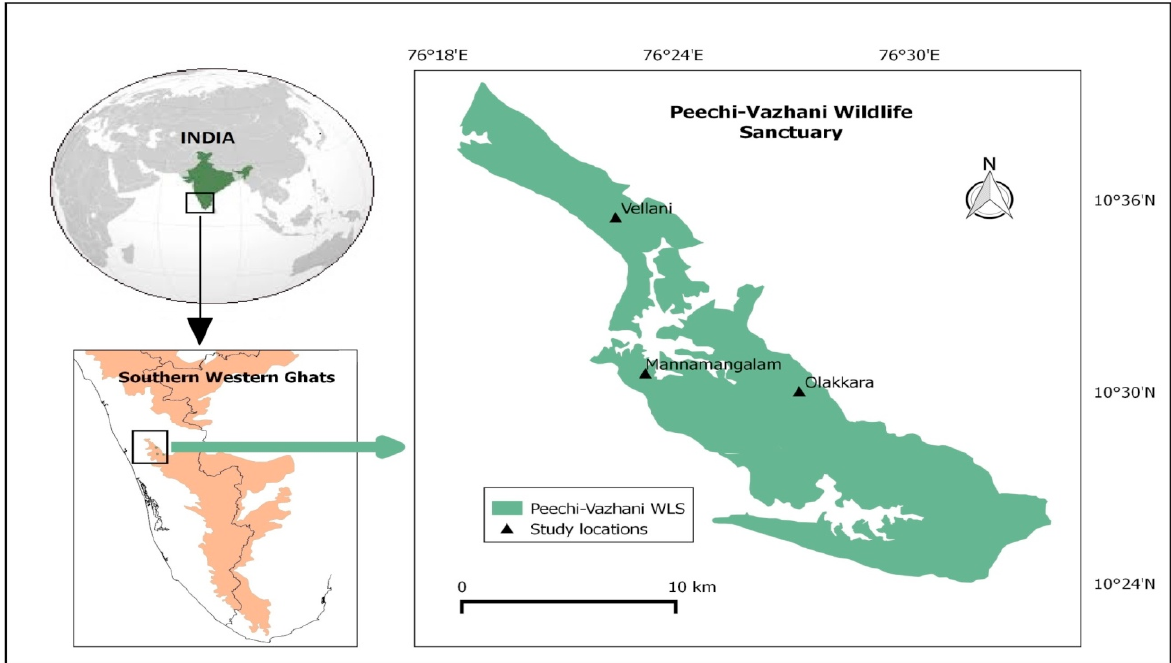
Figure 1. Location map of the study area in Peechi-Vazhani Wildlife